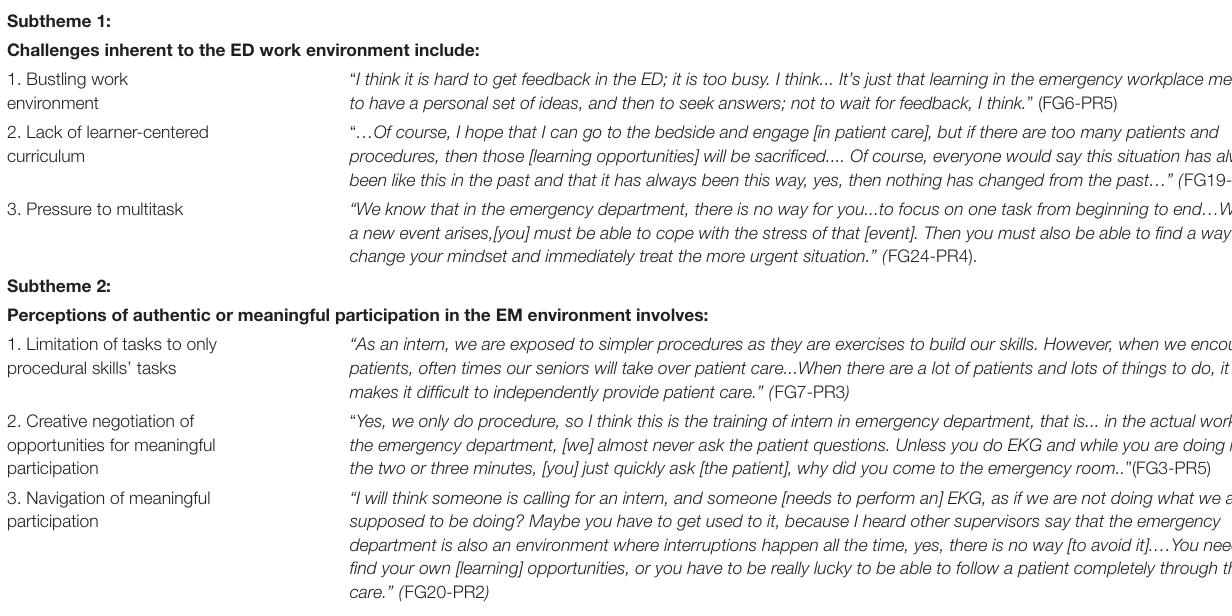
TABLE 2 | Representative quotes of theme 1: Challenges in finding authentic learning experiences within the new environment of emergency